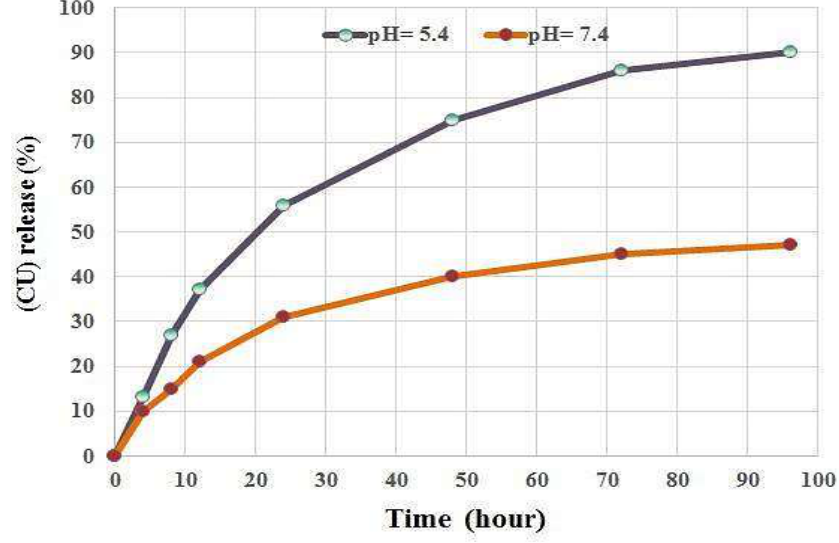
Figure 4. release profile of CU at pH of (7.4 and